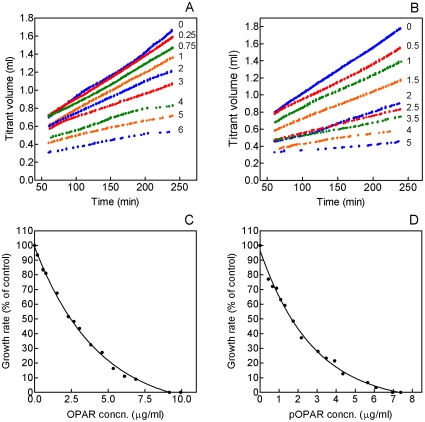
Effects of OPAR and pOPAR on seeded growth of HA.A. Titration curves obtained in the presence of OPAR. Nonlinear parts of the curves (0–60 min) have been omitted. Labels represent concentration in µg/ml. B. Plot of HA growth rate (see panel A) against OPAR concentration. The half-life of the one-phase exponential-decay curve (IC50) is 2.97. C. Titration curves obtained in the presence of pOPAR. Nonlinear parts of the curves (0–60 min) have been omitted. Labels represent concentration inµg/ml. B. Plot of HA growth rate (see panel C) against pOPAR concentration. The half-life of the one-phase exponential-decay curve (IC50) is 1.93.